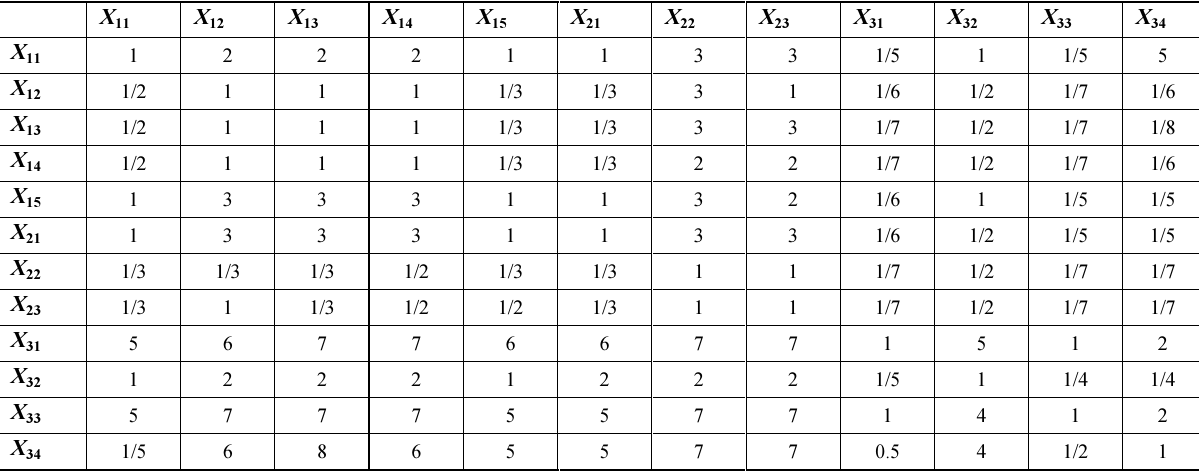
Table 3. Significance of the criteria matrix X 11